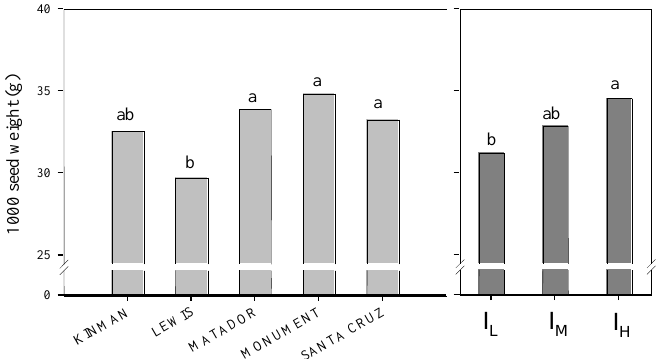
Figure 4. Two-year 1000-seed weight ( left ) of five guar cultivars across three water regimes and ( right )